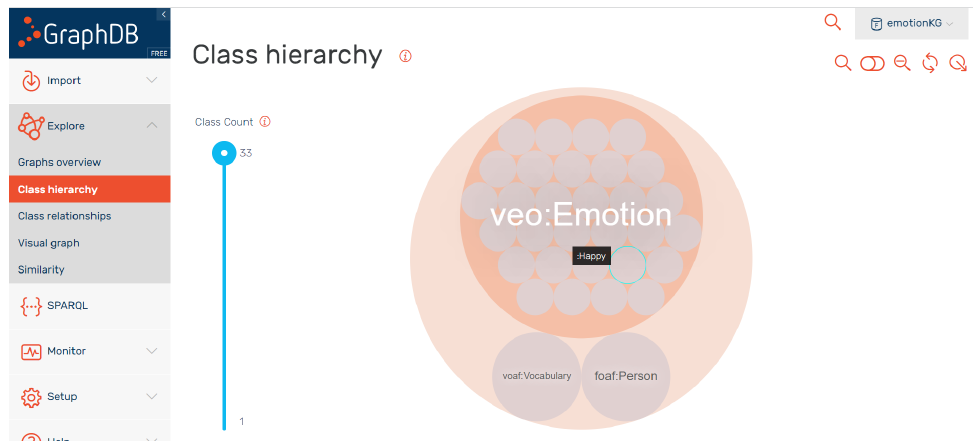
Figure 7. Subset of the emotion ontology (visualization under GraphDB).